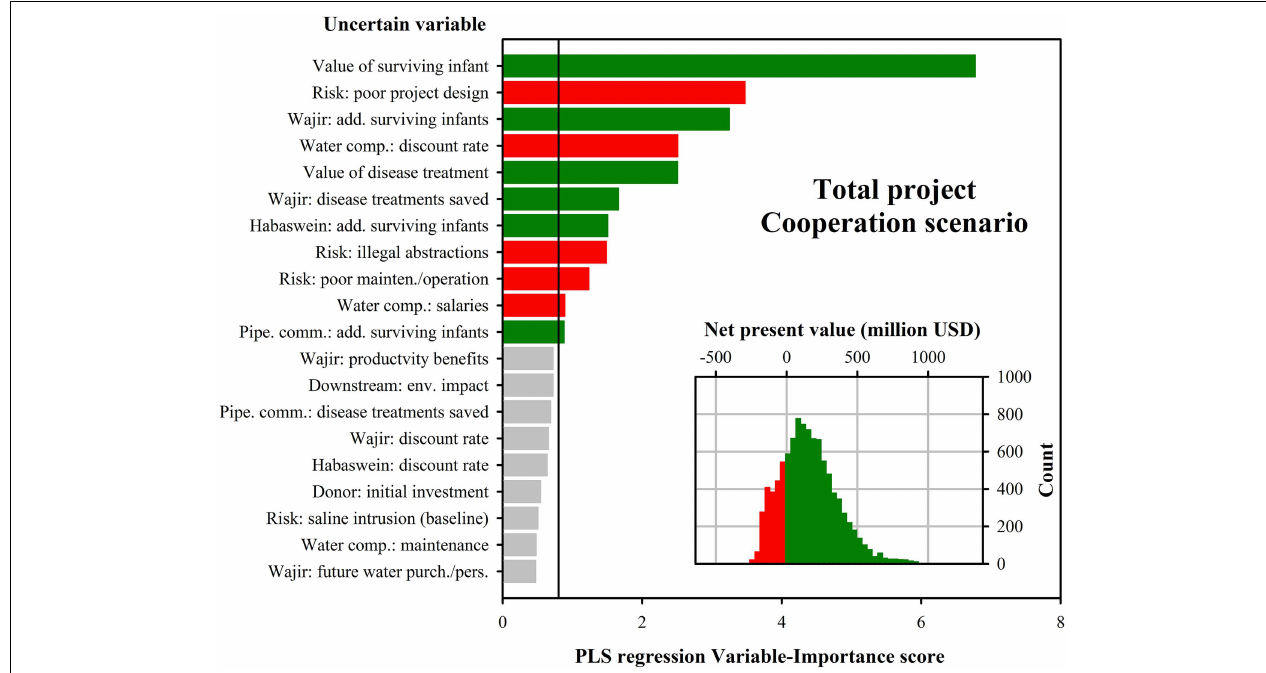
FIGURE 6 | Key sources of uncertainty in projecting outcomes of the overall project for the “cooperation” scenario, as identified by Partial Least Squares (PLS) regression. For a detailed description of the plots, see legend to Figure 5 .